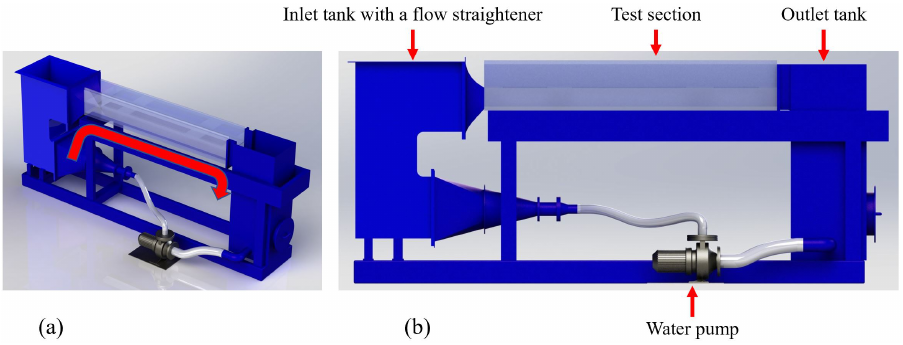
Figure 1. A 3D illustration ( a ) and side-view ( b ) of the flume facility with its main components. The red arrow on the left picture indicates the water flow direction.